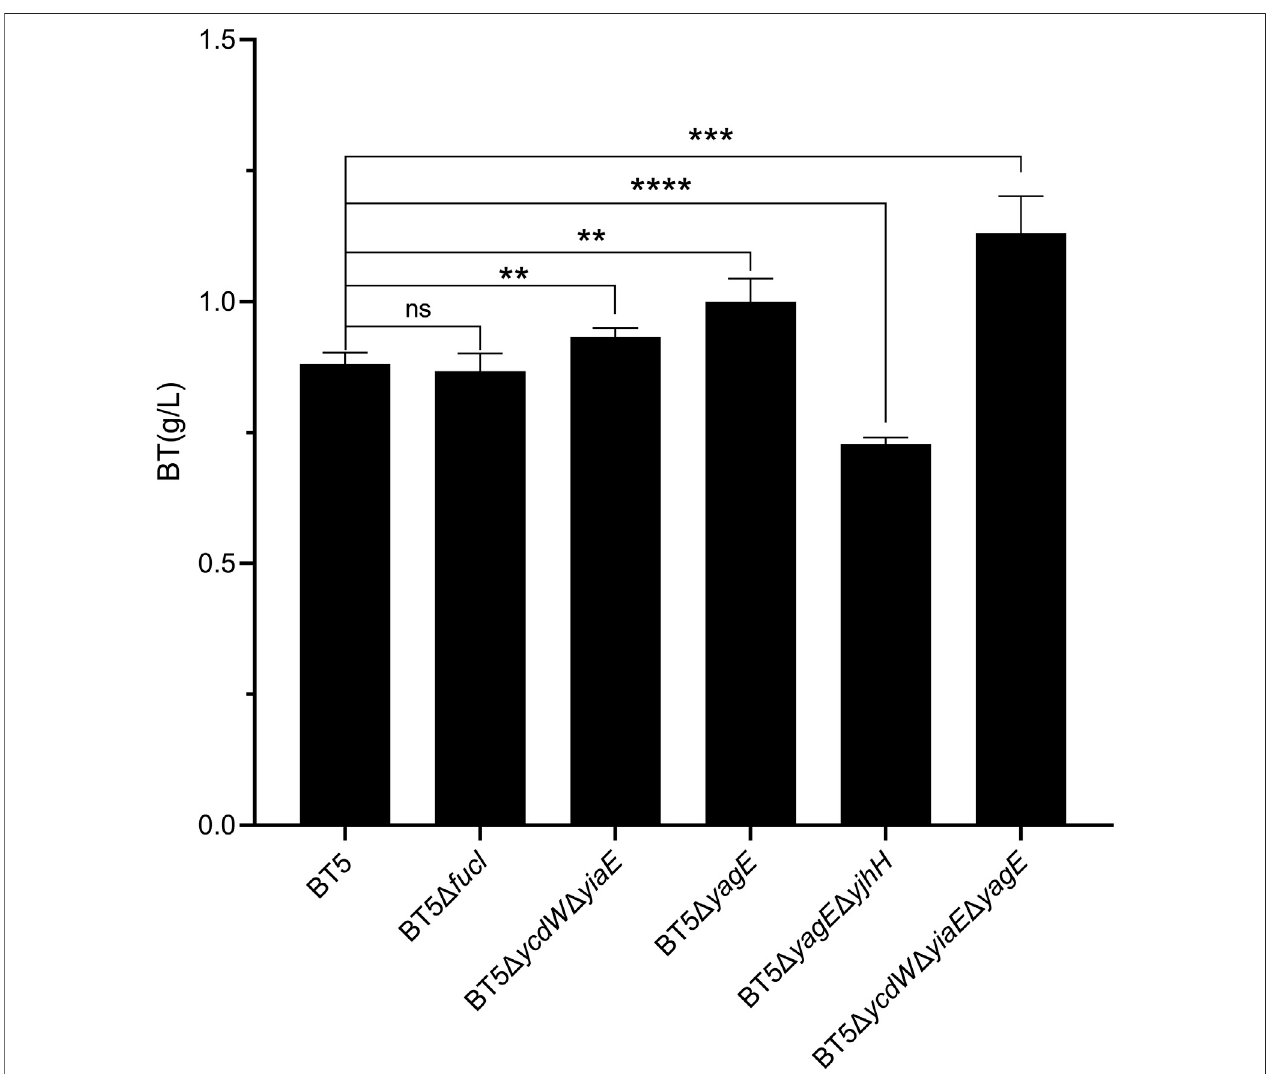
FIGURE4| TheBTproducedbythemetabolicengineeredT1seriesstrainsaftercatalyzingfor48 h.AllofthesesixstrainsharboredtheplasmidpCWJ-AraD-AdhP and pTrc99a-KivD-ADG. Statistical analysis was performed using Student ’ s t-test (two-tailed; * p < 0.05; ** p < 0.01; *** p < 0.005; **** p < 0.001; ns, no signi fi cant difference). Error bars represent SD ( n =